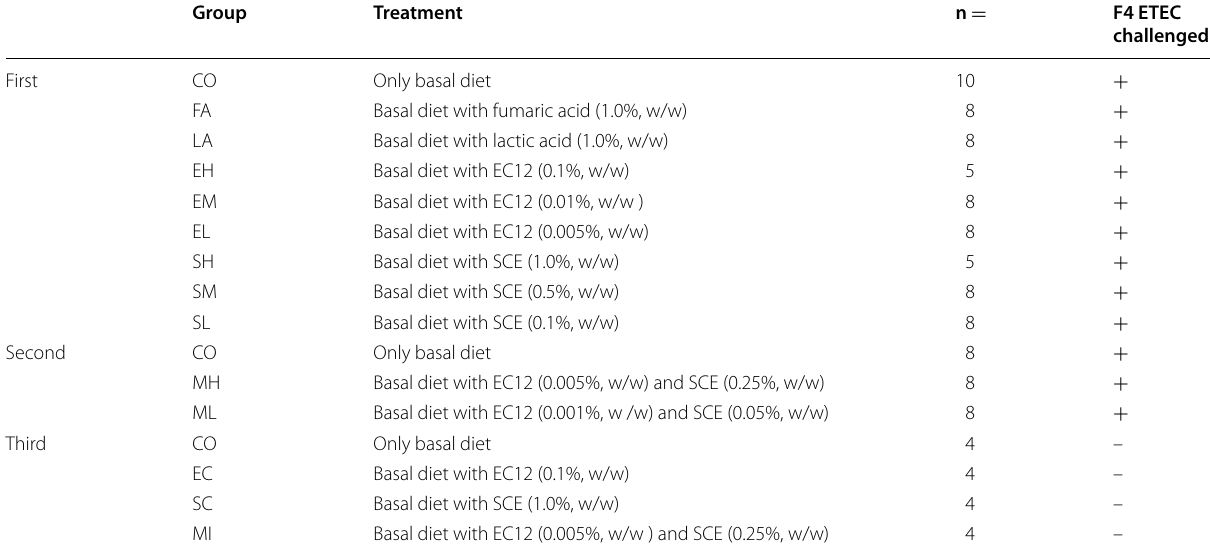
Table 2 Animal experimental design (treatment, number of animals, ETEC infection) in this study